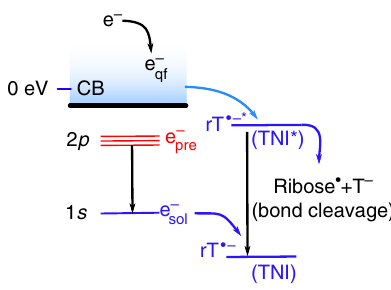
Fig. 1 A schematic diagram of energy level showing different states of electrons during trapping and relaxation. These processes take place in a polar medium following ionizing radiation in the presence of ribothymidine (rT). An excess electron in the conduction band (CB), representing a quasi- free electron (e qf - ), eventually becomes trapped (e sol - ) in the solvent cage. The excited state of e sol - is considered as a "presolvated" electron, e pre - . Electrons captured by solute molecules produce transient negative ions (TNI or rT (cid:129) ‒ ). The TNI in its excited state (TNI * ) can either liberate the excess energy to the solvent (relaxation) or undergo bond breaking